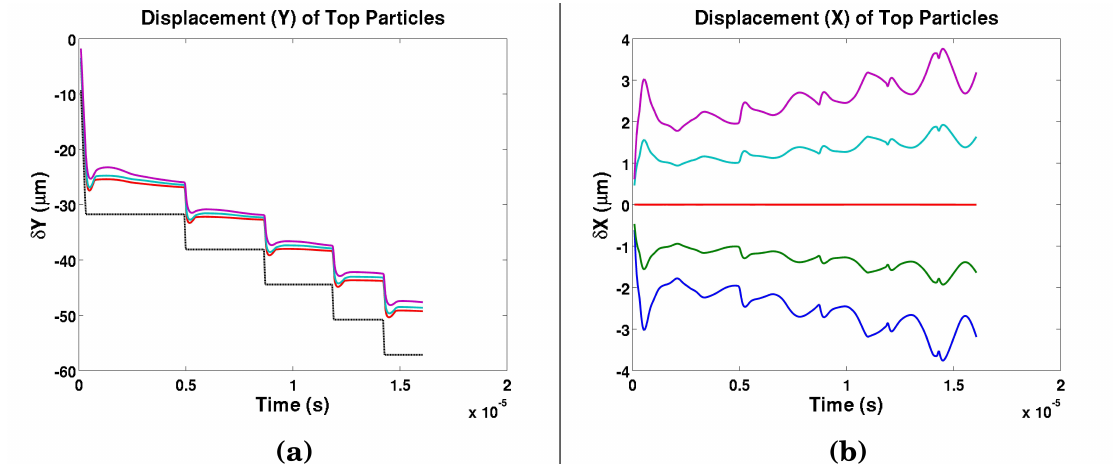
Figure 4. The displacement, where each line represents the displacement of a specific mass particle in the ( a ) y and ( b ) x direction, for the top five center-most particles. The black dashed line in ( a ) represents the forced displacement of the infinitely-stiff